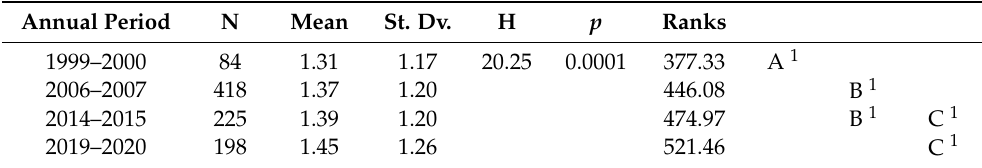
Table A4. Shape Index’s Kruskal Wallis tests between time periods.